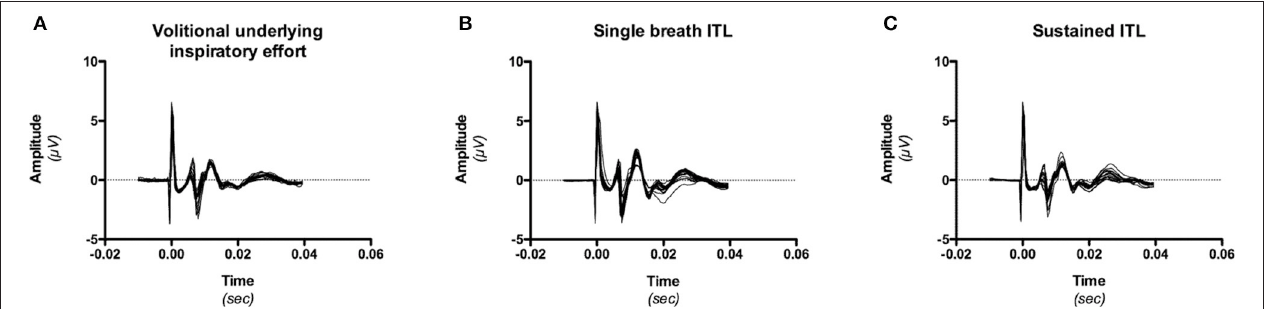
FIGURE 1 | Example, in one subject (# 9) of M-wave consistency during the three experimental conditions [volitional underlying effort, (A) ; single breath inspiratory threshold loading (ITL), (B) ; sustained inspiratory threshold loading (ITL), (C) ]. M-wave could differ in shape and amplitude between conditions (in line with known effects of lung volume and thoracoabdominal configuration), but were consistent within a given conditon (see “data management” in “Methods,” 2.5.2).